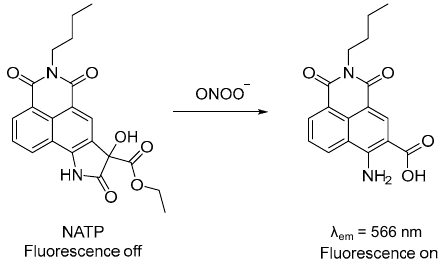
Figure 12. Response mechanism of NATP to ONOO − [68].